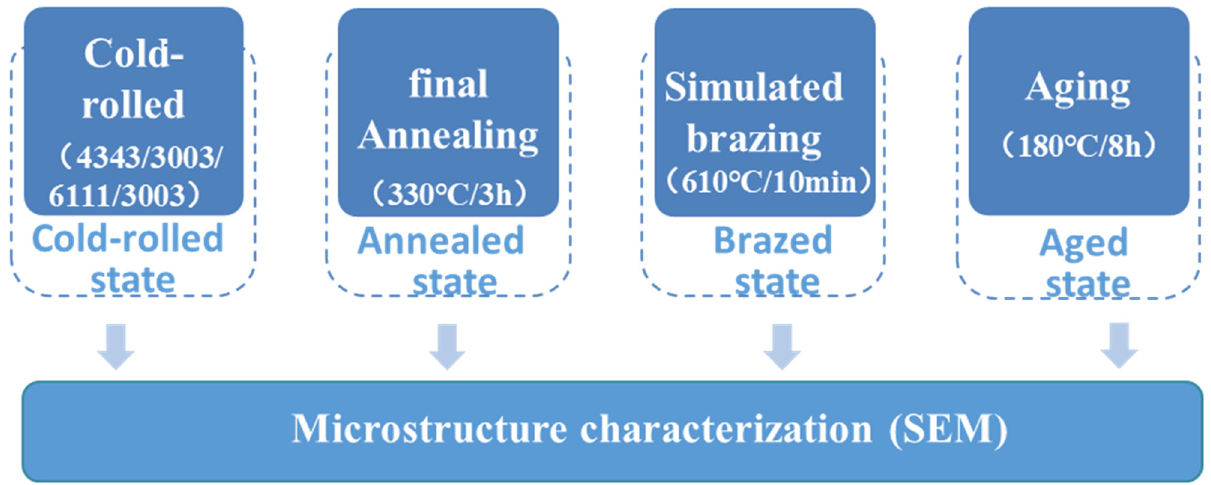
Figure 2. Schematic illustration of the experiment.